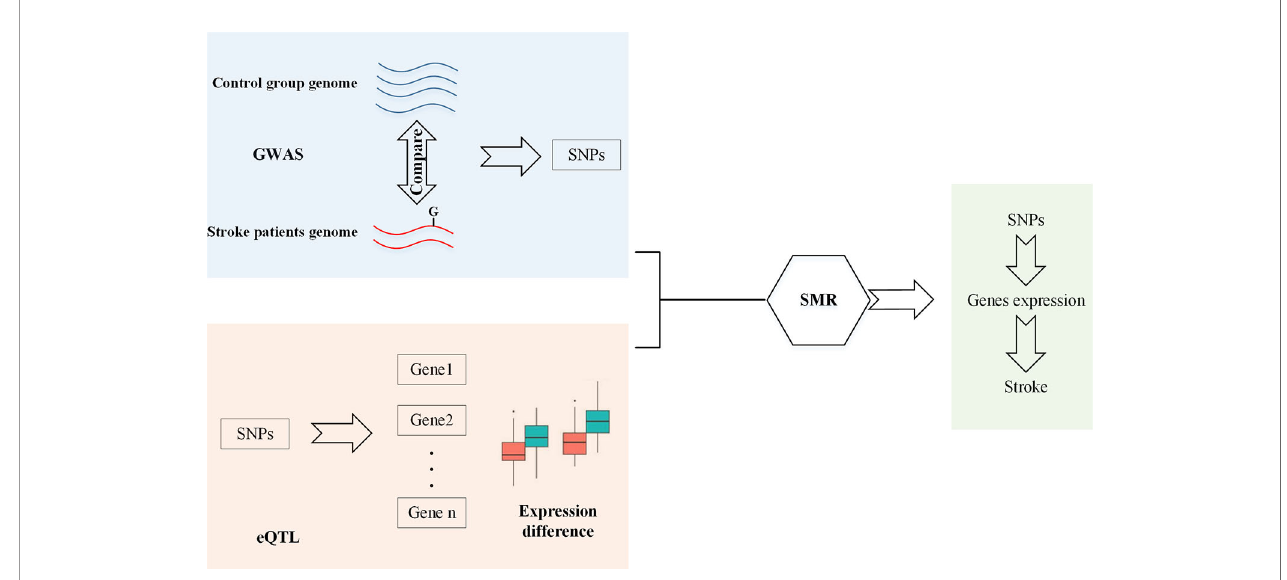
FIGURE 1 | Work fl ow of